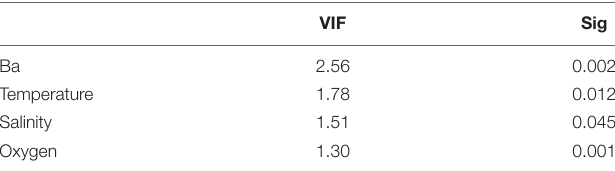
TABLE 4 | Value of variance influence factor and statistical significance of selected variables used in final version of canonical correspondence